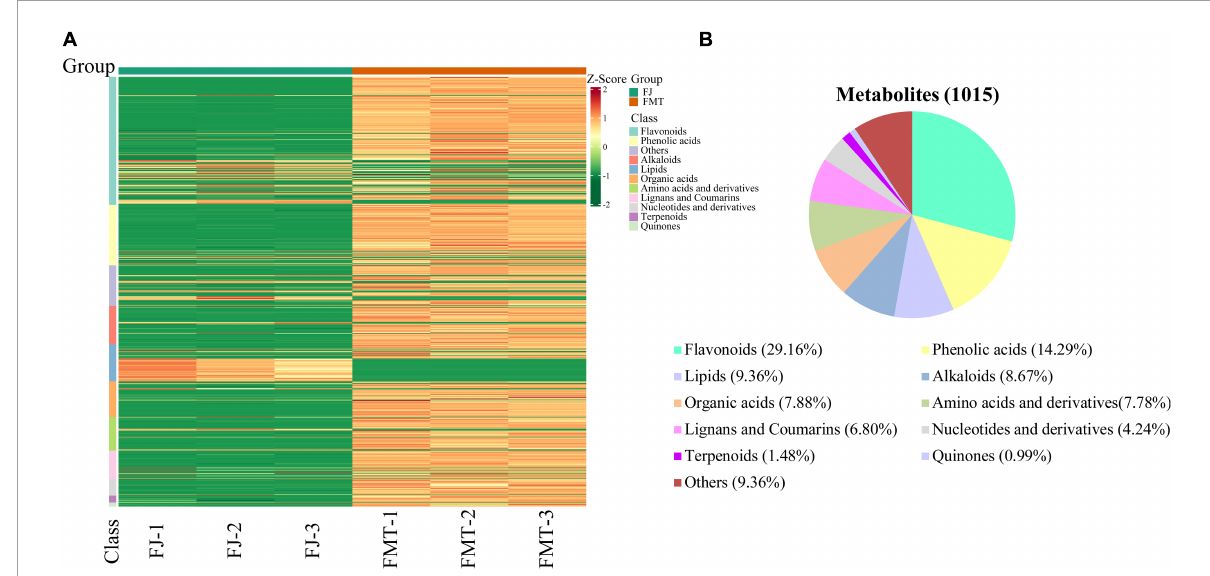
FIGURE1 Heatmap visualization and proportions of the metabolites identified from grapefruit juice (FJ) and grapefruit fermented juice (FMT). (A) Heatmap visualization. The content of each metabolite was normalized to the complete linkage hierarchical clustering. Each example is visualized in a single column, and each metabolite is represented by a single row. Red indicates high abundance, whereas metabolites with low relative abundance are shown in green (the color key scale is right of the heat map). (B) Types and proportions of the metabolites identified from FJ and